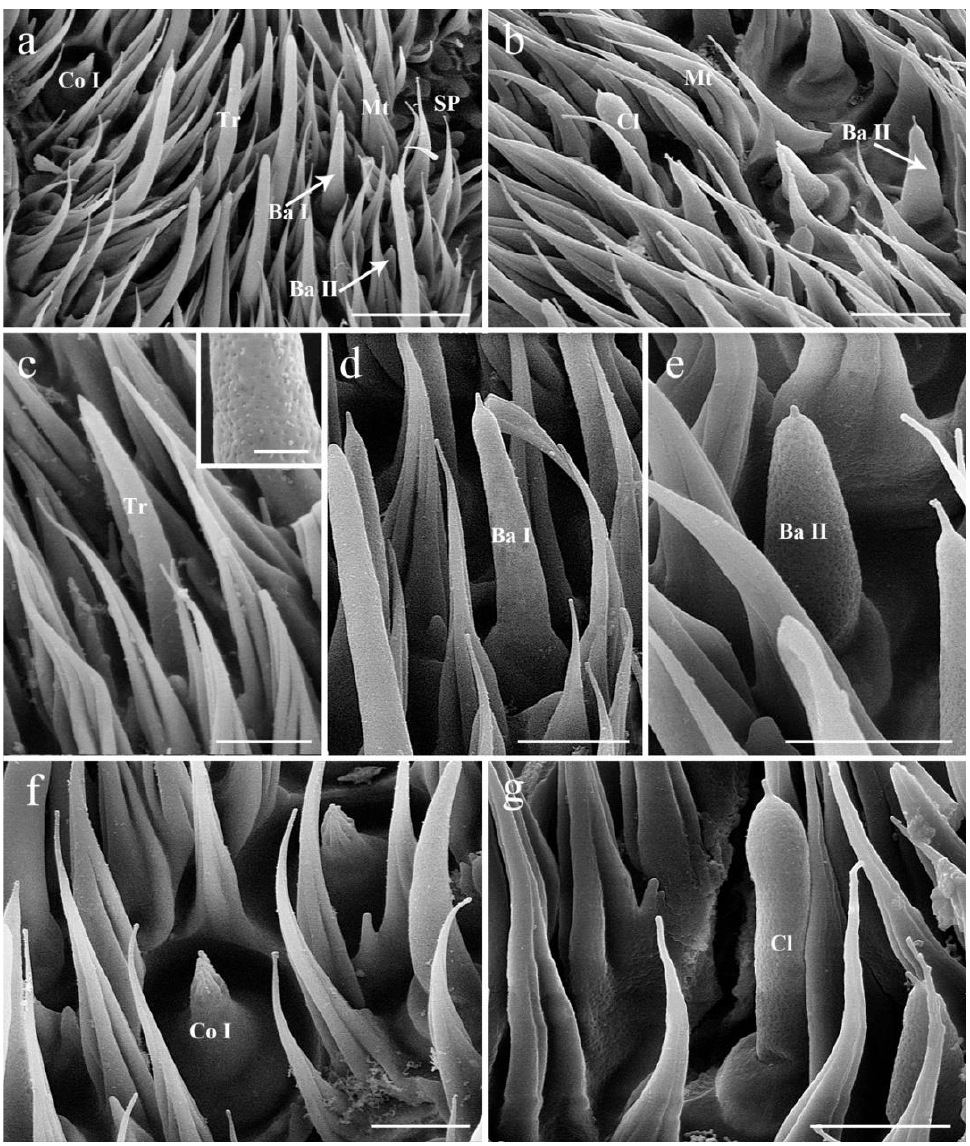
Figure 2. Scanning electron micrographs of the sensilla on postpedicel in female Gyrostigma rhinocerontis . ( a , b ) Distribution of sensilla on the postpedicel surface. ( c ) Trichoid sensillum, showing numerous pores on surface in box. ( d ) Basiconic sensilla I. ( e ) Basiconic sensilla II with cuticular wall pierced by obvious pores. ( f ) Coeloconic sensillum I, set in shallow depression on postpedicel surface. ( g ) Clavate sensillum penetrated by numerous pores on cuticular wall. Scale bars: ( a ) = 15 µ m, ( b ) = 10 µ m, ( c – g ) = 5 µ m. Abbreviations: Ba I, basiconic sensillum I; Ba II, basiconic sensillum